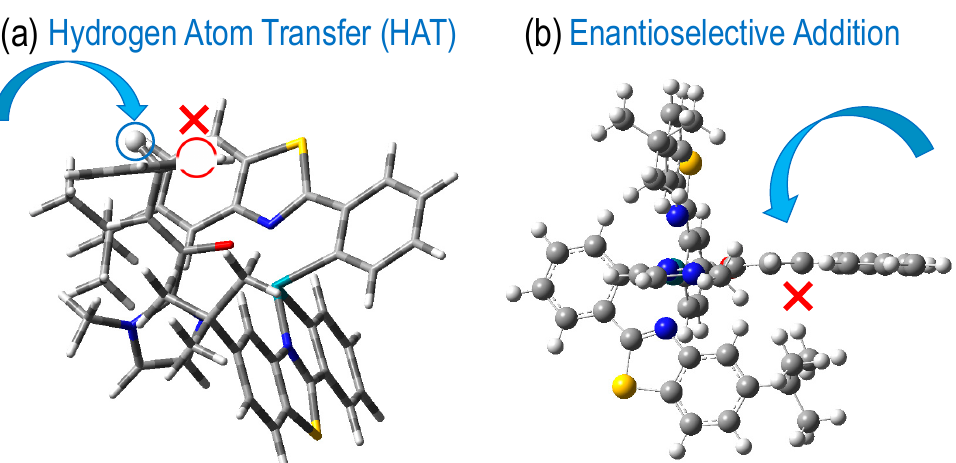
Figure 4. ( a ) Tube model of compound I . The two hydrogens in the β -position that can be taken in the hydrogen atom transfer (HAT) are in a ball and are highlighted for easier identification. ( b ) Side view of compound II , where the sterical hindrance of one of the faces in the addition reaction is clearly shown.